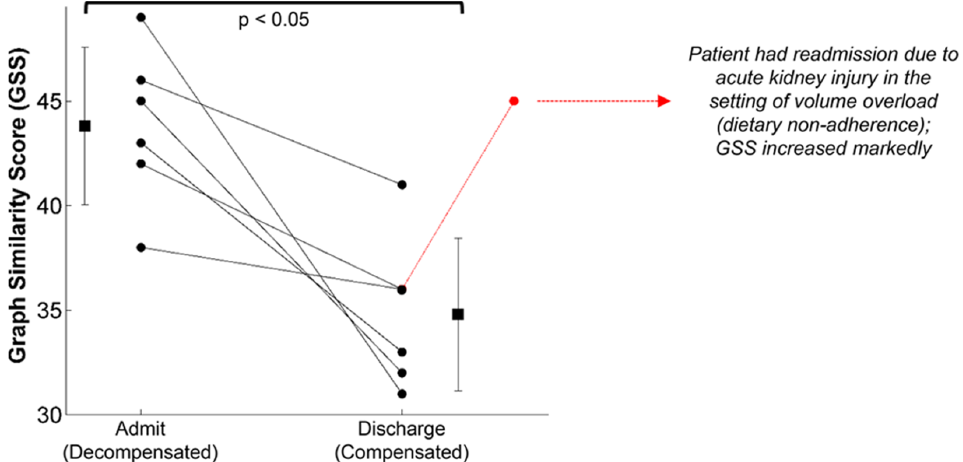
Figure 14. The graph similarity score representing structural differences in the SCG signal recorded from a wearable patch found significant differences between compensated and decompensated heart failure patients from admission to discharge. Though all patients improved following treatment, some patients responded much better to the treatment than others. Image from [64].